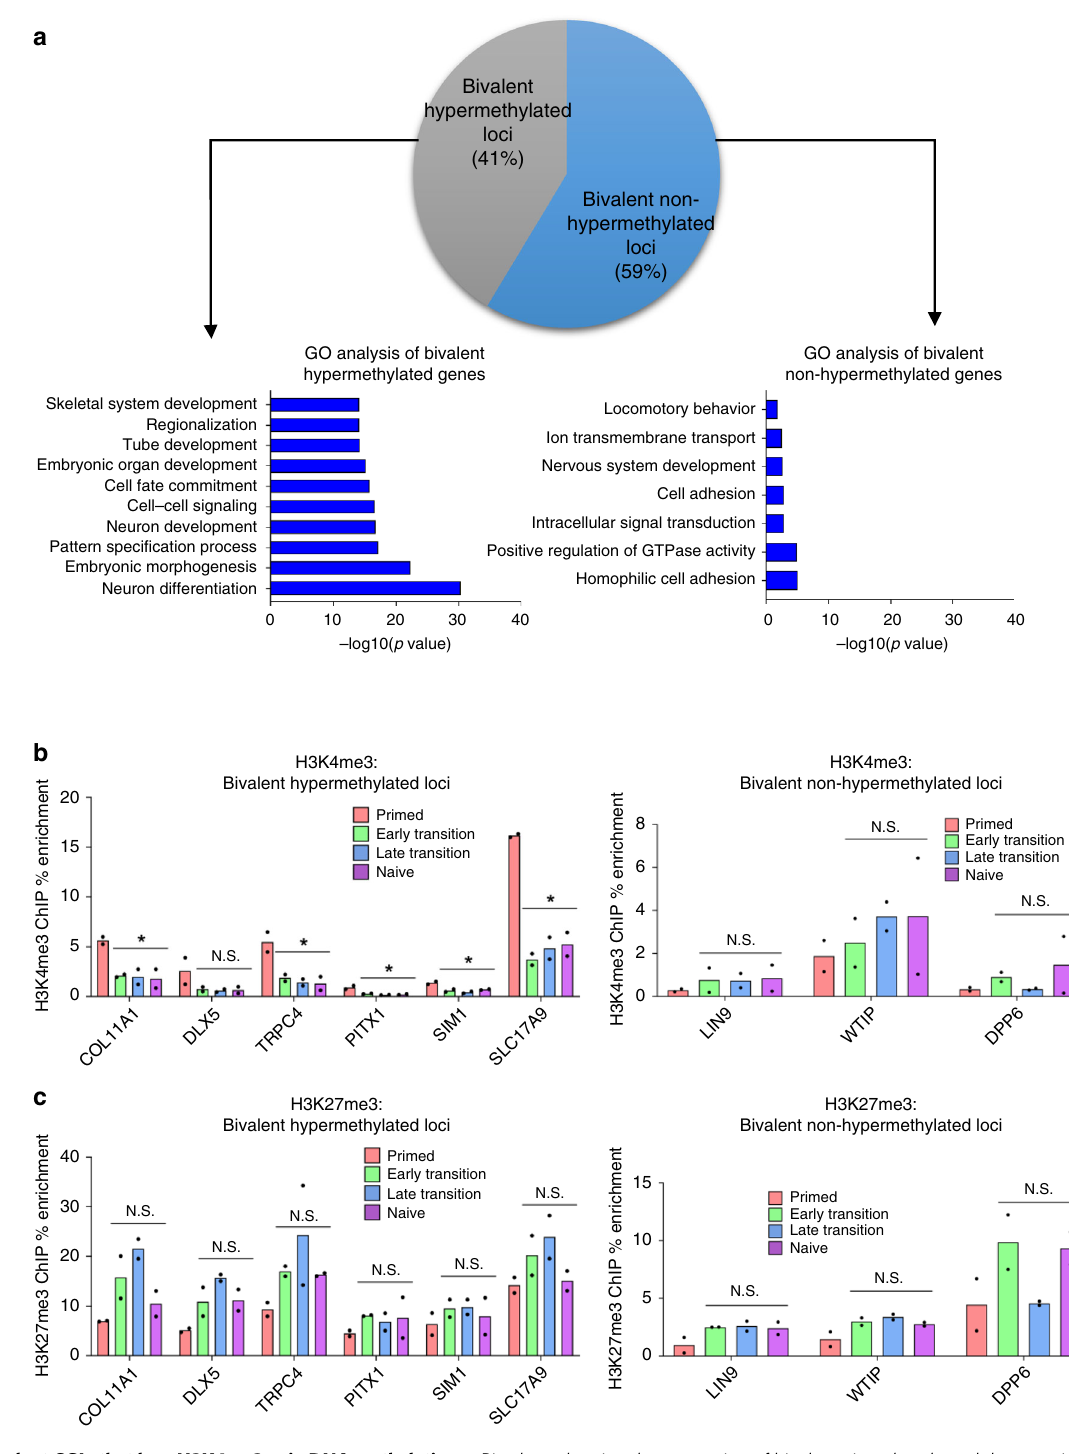
Fig. 5 Bivalent CGIs that lose H3K4me3 gain DNA methylation. a Pie chart showing the proportion of bivalent sites that do and do not gain methylation in naïve hESCs, and gene ontology analysis of these bivalent hypermethylated and non-hypermethylated genes respectively. b ChIP-qPCR enrichment of H3K4me3 and ( c ) H3K27me3 are shown for six candidate bivalent regions (possessing both H3K4me3 and H3K27me3 histone modi fi cations in primed cells) that become hypermethylated, and for three candidate bivalent regions that fail to become hypermethylated during resetting (bottom row). Data are shown as the signal enrichment relative to the input sample with bars representing the mean of two independent experiments. Statistical difference between samples was analysed by a one-way ANOVA test, with Bonferroni post hoc test of each time point compared to primed hESC. * indicates p < 0.05. Source data are provided as a Source Data fi